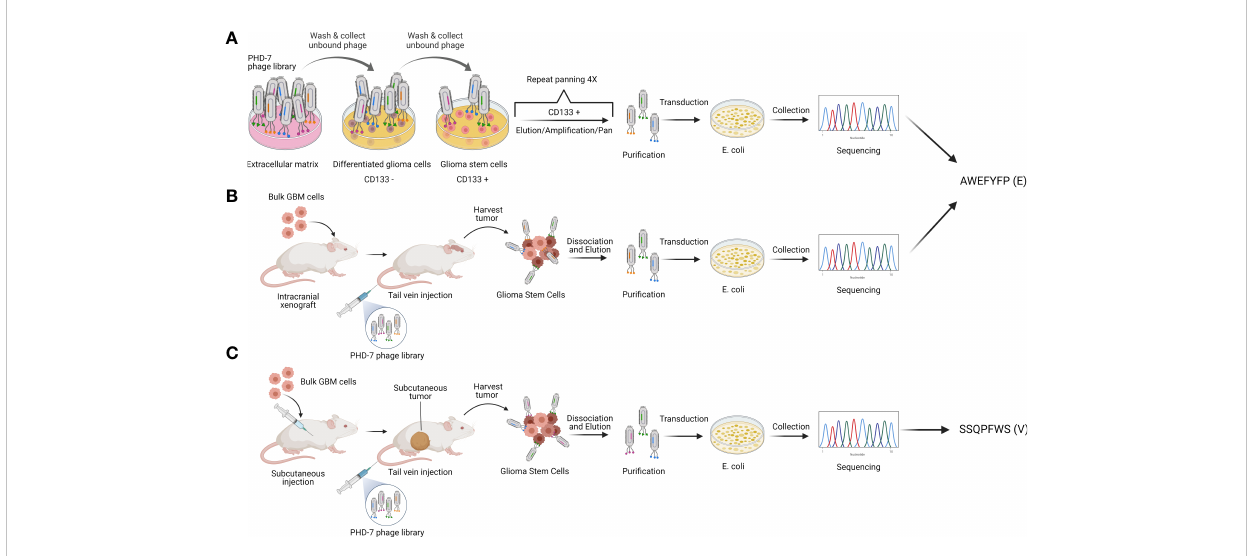
FIGURE 1 Peptide selection. Schematic representation of phage display strategies used to isolate the GSC-targeting peptides E (AWEFYFP) and V (SSQPFWS). (A) In vitro and (B) in vivo biopanning resulted in the identi fi cation of peptide E as one of the most enriched. (C) In vivo biopanning on subcutaneous tumors identi fi ed peptide V as one of the most enriched. Authors ’ elaboration based on prior data from (22,